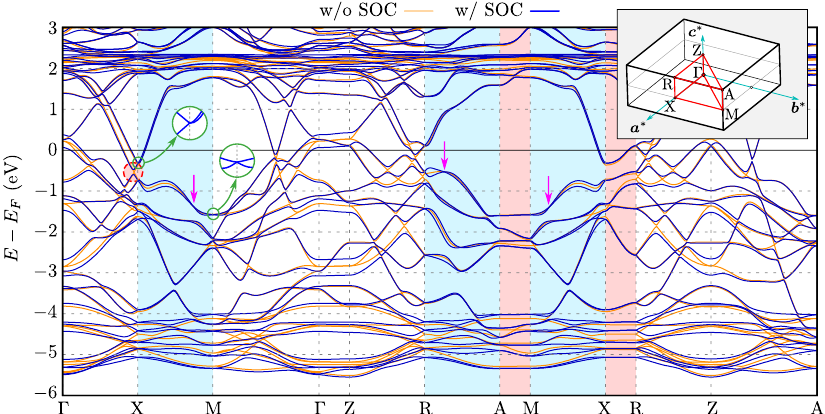
Figure 2. The bulk band structure in the absence and presence of the spin–orbit coupling (orange and blue lines, respectively). X–M and R–A paths, where nodal lines can be realized due to vanishing spin– orbit splitting, are marked with blue background. Similarly, X–R and A–M paths are highlighted with red background, where nodal lines with fourfold degeneration exist due to the P4/nmm symmetry. Two circular insets highlight the bulk Dirac cones at the X and M points. The top right inset presents the Brillouin zone of the tetragonal structure P4/nmm and its high-symmetry points